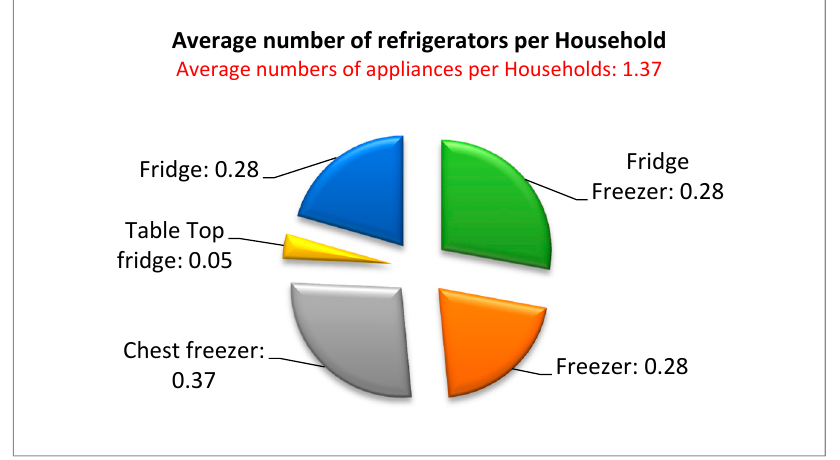
Figure 3. Average number of cold appliances per household (Source: [5]).